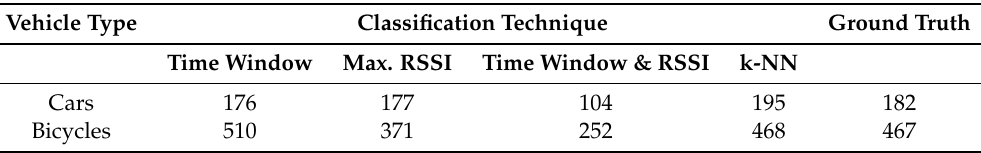
Table 4. Number of vehicles detected by the algorithm, according to vehicle type and classification technique for Heisenbergstrasse.